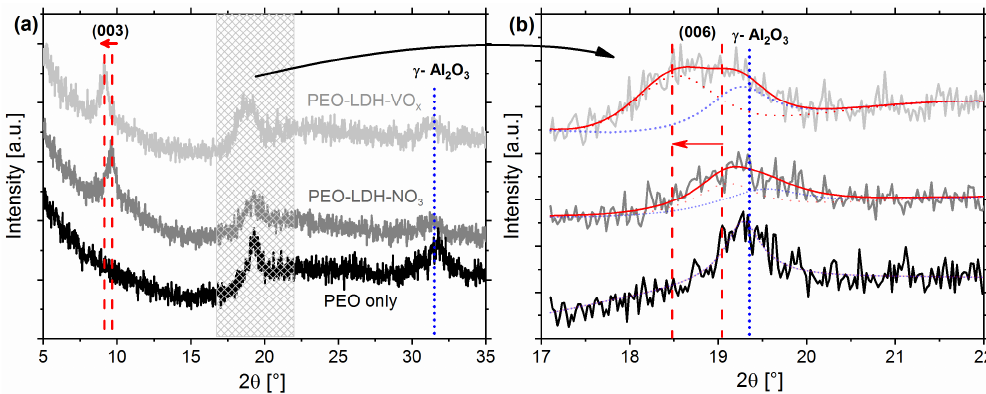
Figure 1. ( a ) Grazing incidence (3 ◦ ) X-ray diffraction patterns of the PEO sample, PEO sample with Zn-Al layered double hydroxide-nitrate (LDH-NO 3 ), PEO sample with Zn-Al LDH-vanadate (LDH-VO x ). ( b ) Overlapping peak deconvolution via enhanced peak fitting.